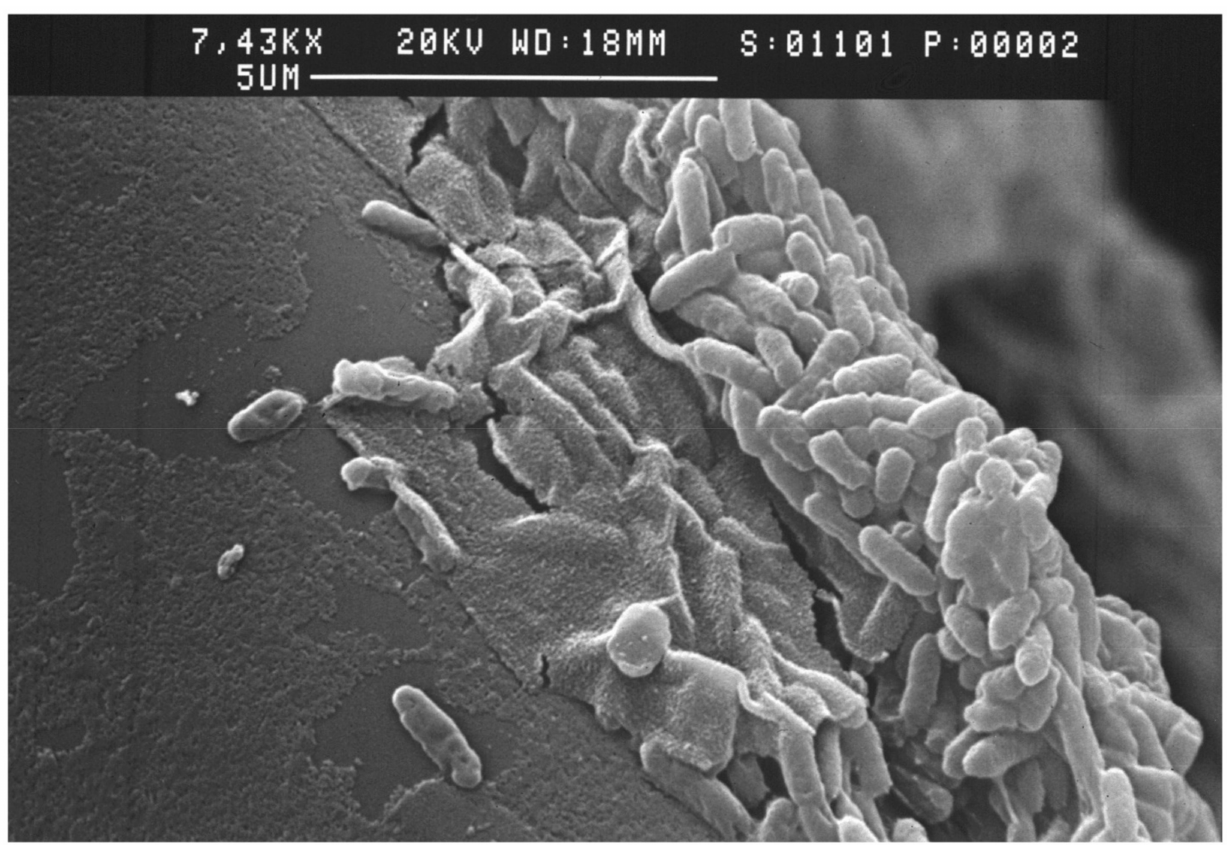
Figure 4. Formation of P. aeruginosa biofilms on glass wool as observed by scanning electron mi- croscopy. This image demonstrates cellular aggregates and the matrix